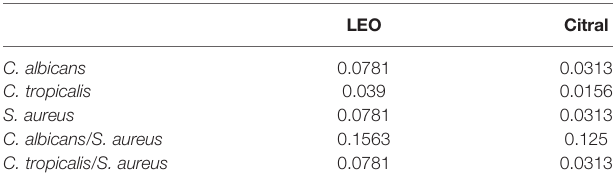
TABLE 3 | MIC (v/v %) of lemongrass essential oil (LEO) and citral against planktonic S. aureus and Candida species.